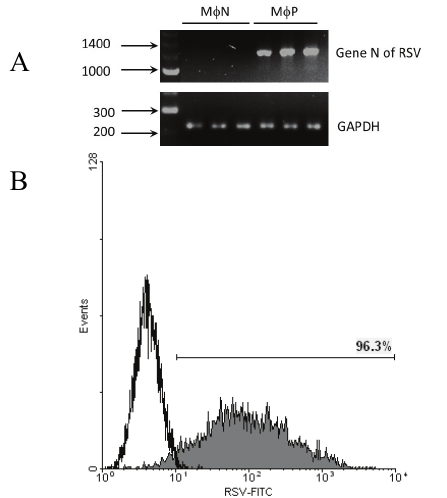
Figure 1. RSV persistence in M φ P. ( A ) Presence of mRNA of the N gene in M φ P. Agarose/EtBr gel (2%) electrophoresis of RT-PCR products. Total RNA from three different passages of M φ P (72, 83 and 87) or M φ N cells was harvested and converted to cDNA. DNA primers for the N gene were used to amplify a segment of 1,187 bp by PCR. As control, a segment of RNA for GAPDH was amplified; ( B ) Expression of RSV antigens on M φ P membrane. M φ N (empty histogram) or M φ P (gray histogram) were stained with FITC-labeled anti RSV antibodies and analyzed by flow cytometry. Histogram is representative of several experiments with different passages of M φ P and M φ N during the course of these experiments.